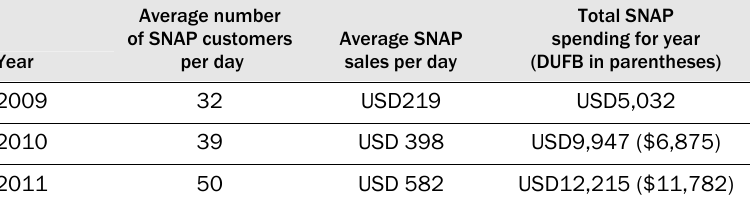
Table 2. SNAP and DUFB a at the WSU Farmers Market